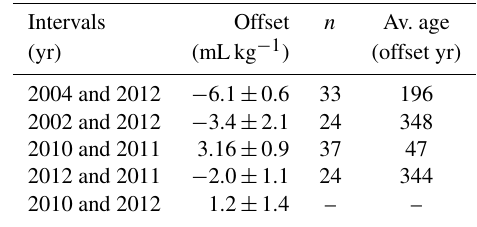
Table 2. Table with the offsets between the data from different mea- suring periods. The second number in the intervals column is the reference period. Offset values are the median of all data points compared. The given error is the standard error. n is the number of points compared. Av. age offset denotes the average difference to the closer endpoint of the interpolation interval. The 2010 data could not be compared directly to 2012, so the offset values in the table are calculated from the other